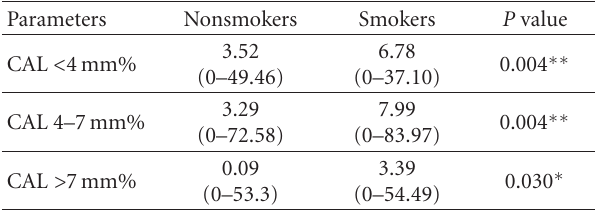
Table 5: Comparison of clinical attachment loss between nonsmok- ers and smokers. Results are presented in trimean (min-max).